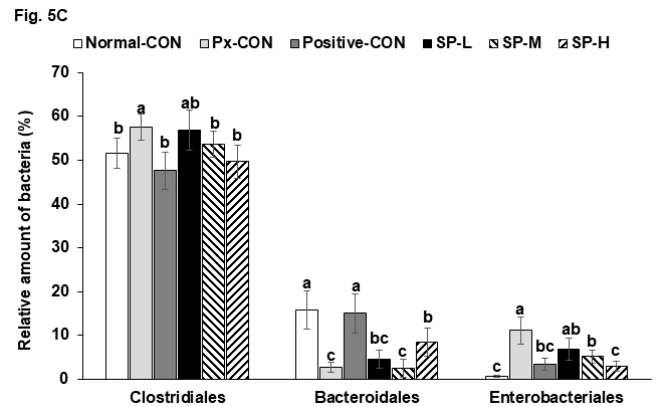
Figure 5. Gut microbiome and area. ( A ). The composition of gut microbiome in the order level. ( B ). The PCoA analysis. ( C ). Relative counts of Bacteroidales, Clostidales, and Enterobacteriales based on total bacteria counts. Dots and error bars represent means ± SD ( n = 8). a,b,c Different letters on bars indicate significant differences ( p < 0.05).